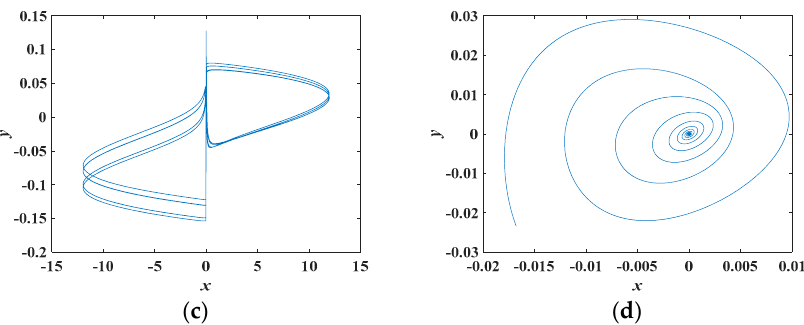
Figure 10. Phase portraits of the periodic and point attractors on the ( x , y ) plane with the different parameters: ( a ) period-1 attractor with c = 0.45; ( b ) period-2 attractor with c = 0.70; ( c ) period-4 attractor with c = 0.78; ( d ) a point attractor with c = 1.5.